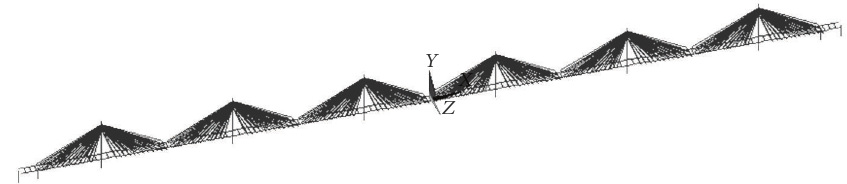
Figure 3: Finite element model of Jiashao Bridge.